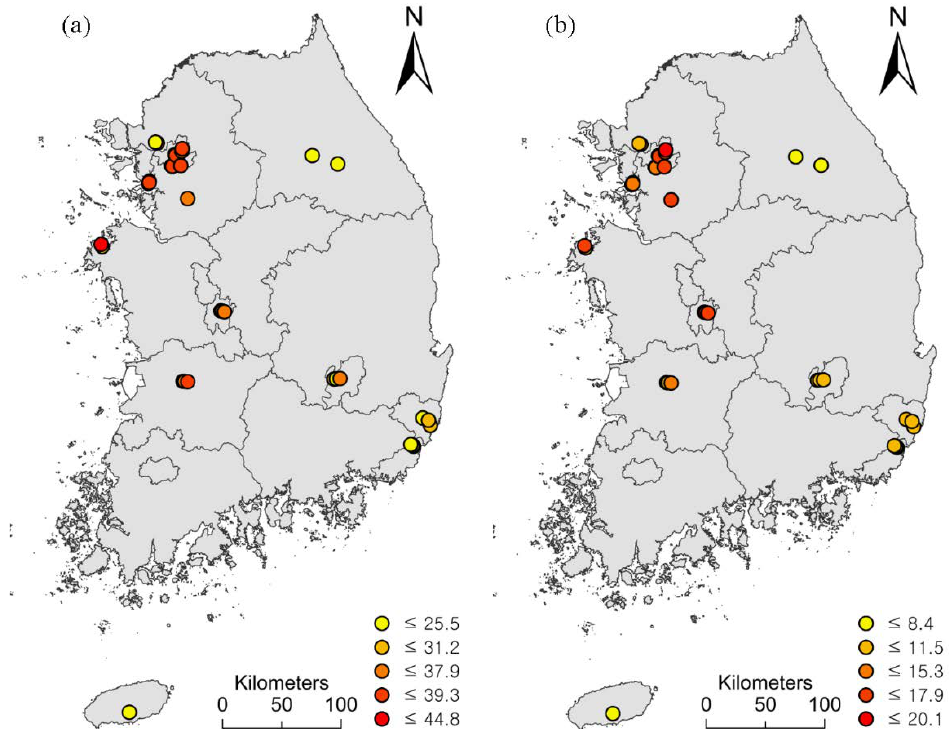
Figure 1. Maps of the study area displaying the locations of PM 2.5 monitoring stations with their ( a ) hourly mean PM 2.5 concentration (unit: μg/m 3 ) and ( b ) PRH (unit: hour) during February to ( a ) hourly mean PM 2.5 concentration (unit: µ g/m 3 ) and ( b ) PRH (unit: hour) during February to March 2021. March